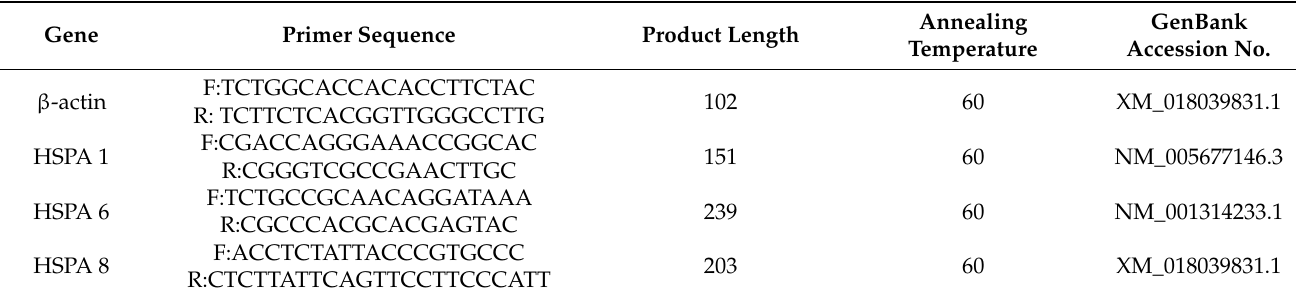
Table 2. Details of the primer